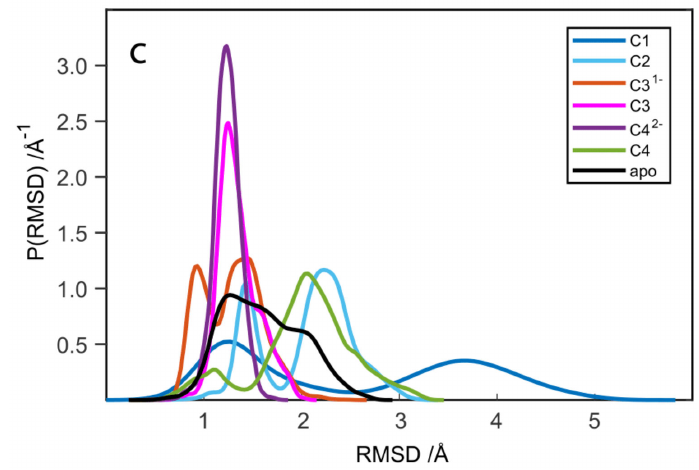
Figure 6. RMSD probability distributions obtained by a kernel density estimate using a normal distribution function. The calculation is done on the protein backbone of the apo -protein (from 2iw1) and the various WaaG-ligand complexes. The panels depict the RMSD distributions for WaaG in complex with ligands of ( a ) library A, ( b ) library B and ( c ) library